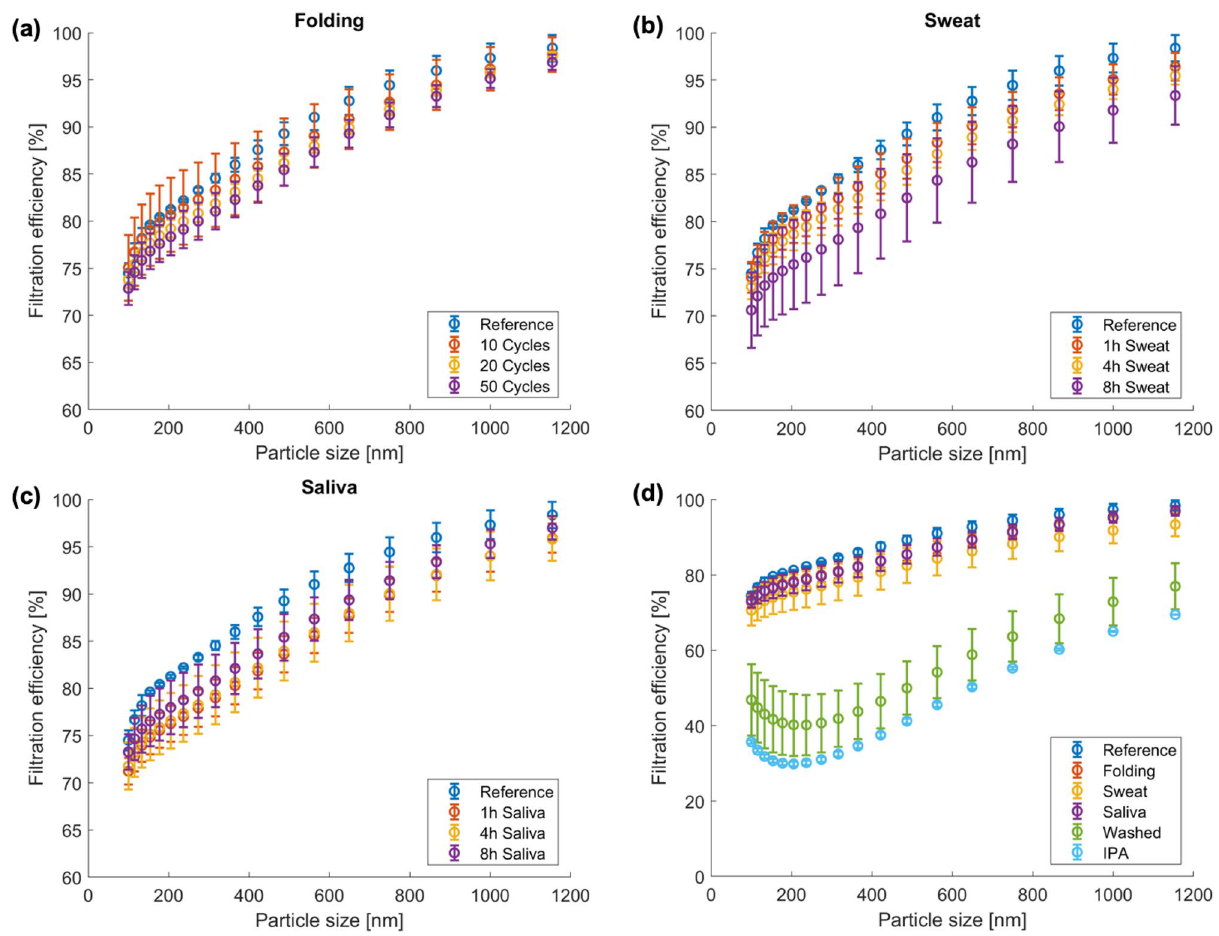
Figure 5. Characterization of the surgical mask’s filtration efficiency after a set of different treatments in order to assess their degree of degradation and so their durability after a given time of use: For each figure the reference data are used as a comparison and are represented by the series of blue points: ( a ) the folded masks; ( b ) the masks aged in sweat; ( c ) the masks aged in saliva; ( d ) comparison of the filtration efficiency at a different scale of the surgical masks type IIR after the different treatment, adding the FE after the washing cycles and the discharging procedure with